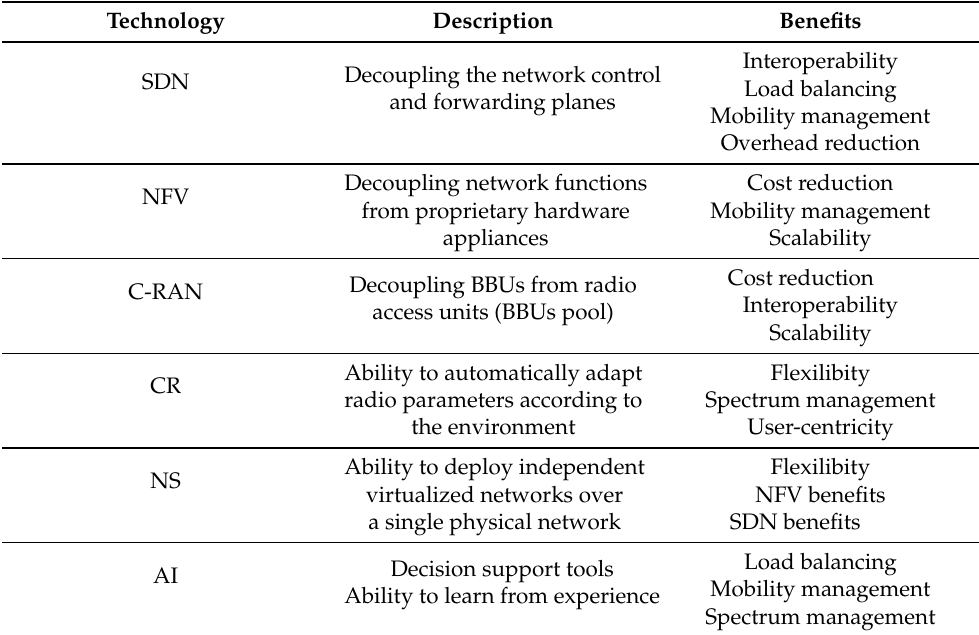
Table 2. Overview of enabling technologies for multi-connectivity in 5G networks and